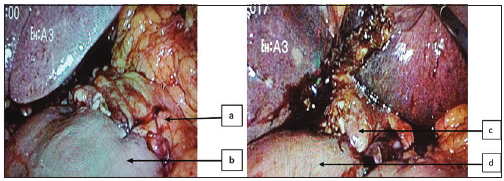
FIGURE 4. (A) Terminolateral pancreaticojejunostomy: (a) Pancreas and (b) jejunum. (B) Terminolateral hepaticojejunos - tomy: (c) Common hepatic duct and (d)